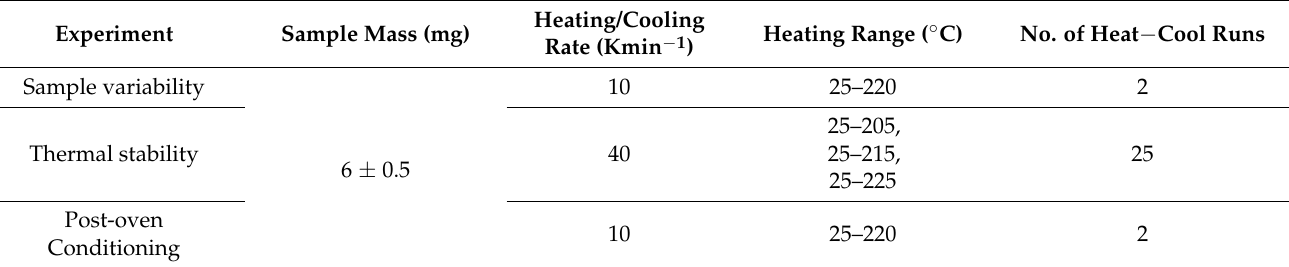
Table 1. Experimental conditions adopted for thermal